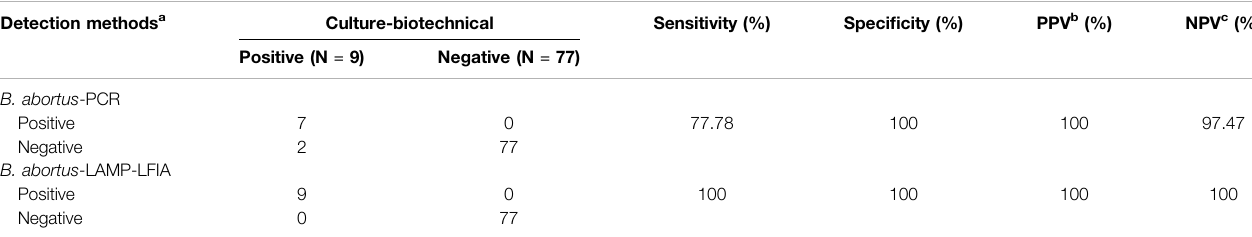
TABLE 4 | Comparison of culture-biotechnical, B. abortus -PCR and B. abortus -LAMP-LFIA assay for the detection of B. abortus in whole blood samples. Detection methods